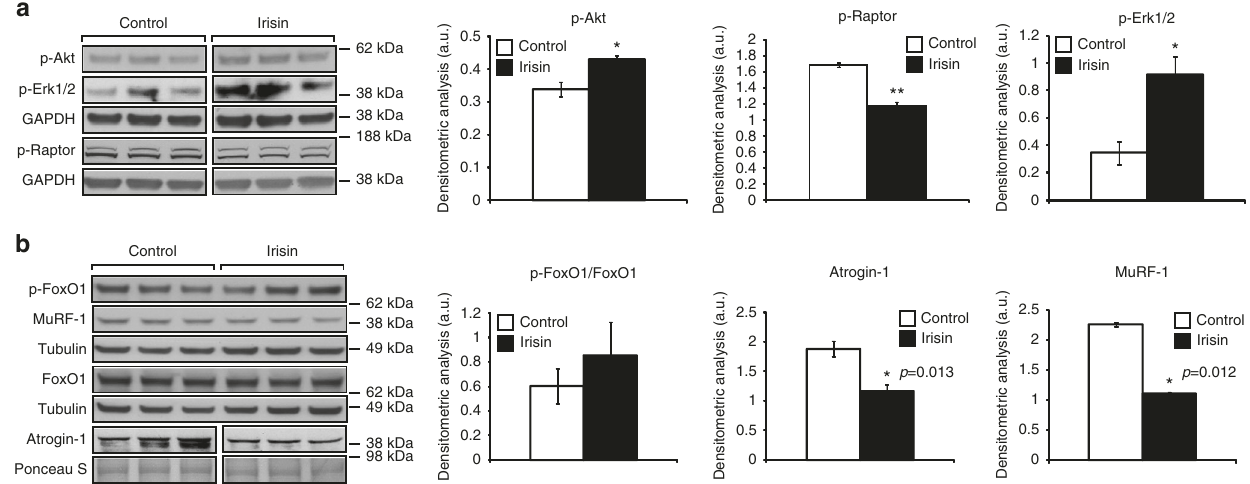
Fig. 5 Signalling behind irisin treatment. a IB analysis of p-Akt, p-Erk1/2, and p-Raptor protein levels. The levels of GAPDH were assessed as a loading control. Graphs show densitometric analysis of p-Akt (left), p-Raptor (middle), and p-Erk1/2 (right) levels in arbitrary units (a.u.), normalized to GAPDH ( n = 3 biological replicates). Since p-Akt and p-Erk1/2 IB analysis was performed on the same membrane, the same GAPDH was used to normalize the results. b IB analysis of p-FoxO1, MuRF-1, FoxO1, and Atrogin-1 protein levels. The levels of tubulin or Ponceau S were assessed as loading controls. Graphs show densitometric analysis of pFoxO1/FoxO1 (left), Atrogin-1 (middle), and MuRF-1 (right) levels in a.u., normalized to tubulin or Ponceau S ( n = 3 biological replicates). Since pFoxO1 and MuRF-1 IB analysis was performed on the same membrane, the same tubulin was used to normalize the results. All IBs were performed on proteins collected from 72 h-differentiated myotubes treated with either DB (control) or irisin (1000 ng/ml) for a further 48 h. Where necessary, intervening irrelevant bands were removed from the IBs, which is denoted by a gap between boxes in the fi gures. Error bars represent mean ± SEM. Student ’ s t -test was performed for all relevant fi gure panels. Signi fi cance is indicated with * p < 0.05 and ** p <